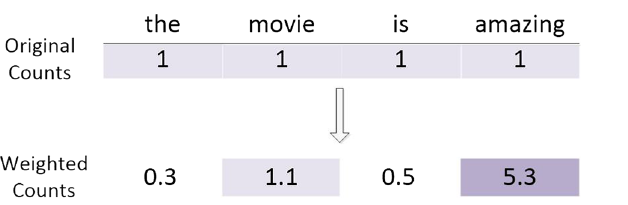
Table 1 Statistics used in this paper and their notations. Only binary classification is considered Notation